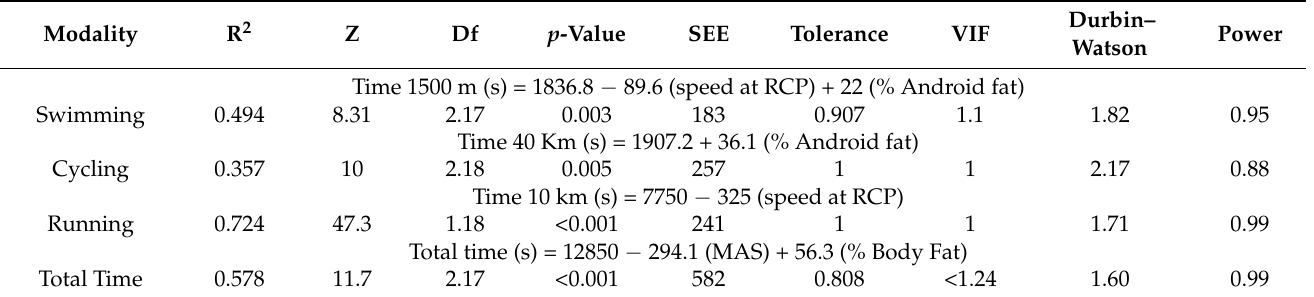
Table 5. Multiple linear regression models for estimating performance in swimming, cycling, running, and total race time for